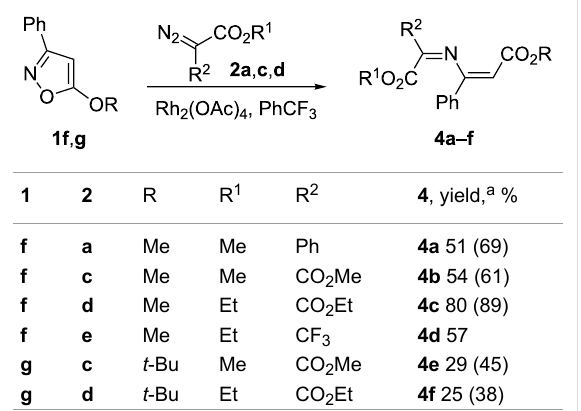
Table 3: Synthesis of 1-oxa-5-azahexa-1,3,5-trienes 4a–f